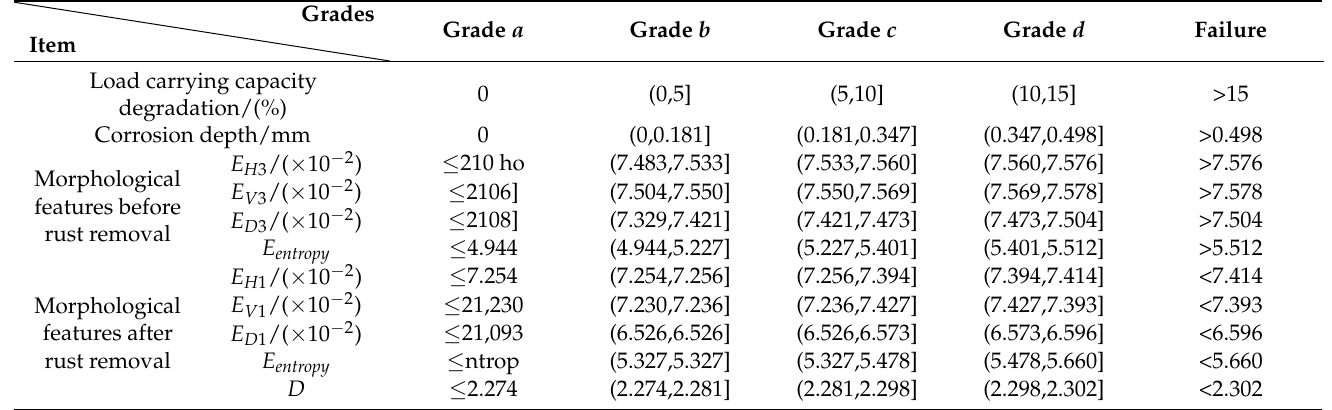
Table 9. Comprehensive safety evaluation of CCSTs under compression.